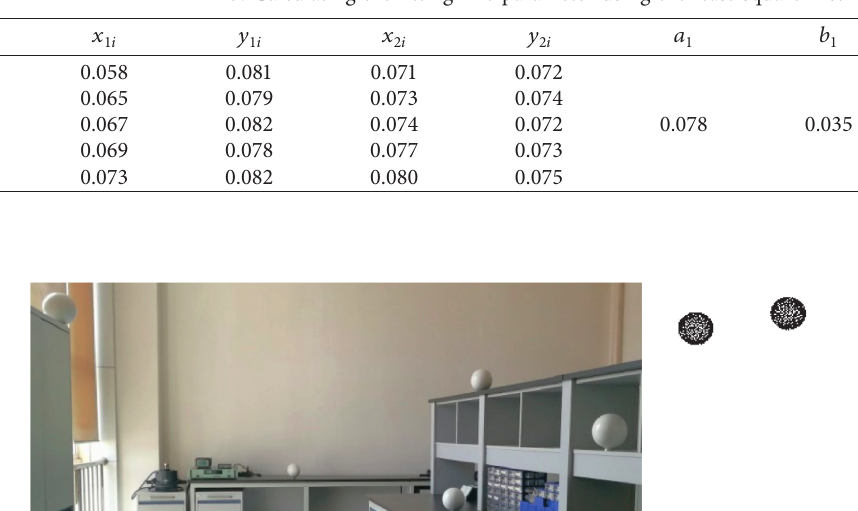
Table 3: Calculating the fitting line parameter using the least-square method.